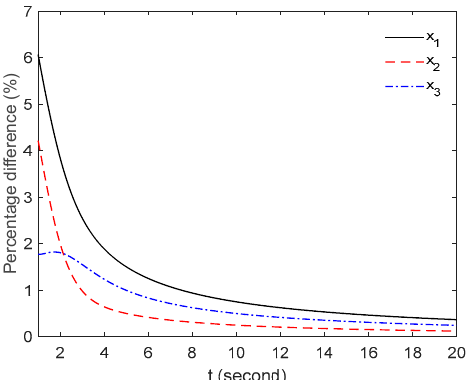
Figure 2. Percentage differences between the exact solutions and the present method.